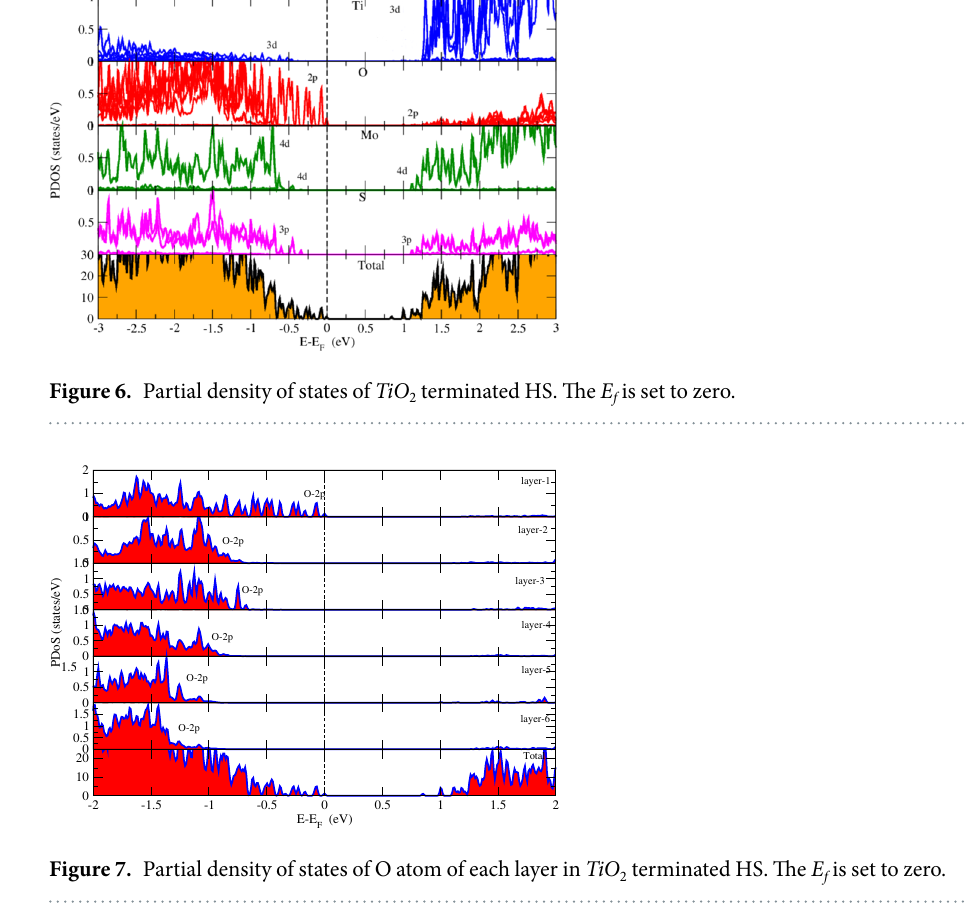
Fig. 2, sitting at the E f is the O-2p states coming from the surface layer of STO. The VBM of HS is composed of O-2p states while CBM is found at 0.85eV with mixed states of Ti-3d, Mo-4d and S-3p. Ti-3d states are present in VB with relatively low intensity PDoS peaks i.e. contribution of Ti in VB is very feeble. Whereas, Mo-4d and S-3p states are clearly seen in both sides of E f . Also, O-2p states are contributing in VB region actively and are found at E f but not crossing it. Low intensity peaks of O-2p states are seen is energy below 1.25 eV in CB region. We studied the contribution of O atoms of each layer of STO to find that O atom of which layer of STO is observed at E f . Fig. 7 shows the O-2p states of each layer of STO. We begin our analysis from the bottom layer of STO. The common character of O-2p states in each layer is that their contribution in CB is almost negligible. The O-2p states of bottom layer of STO are seen in VB from − 1.1eV to far energy range. They are absent near E f . As we move to the surface layer of STO, the contribution of O-2p states are getting more close to E f and at the surface layer, O-2p states are found exactly at the E f but they are not crossing it. These surface O atoms with Mo-4d states of monolayer are giving rise to the existence of energy gap as maximum of VB is composed of O-2p states and minimum of CB is composed of Mo-4d states.